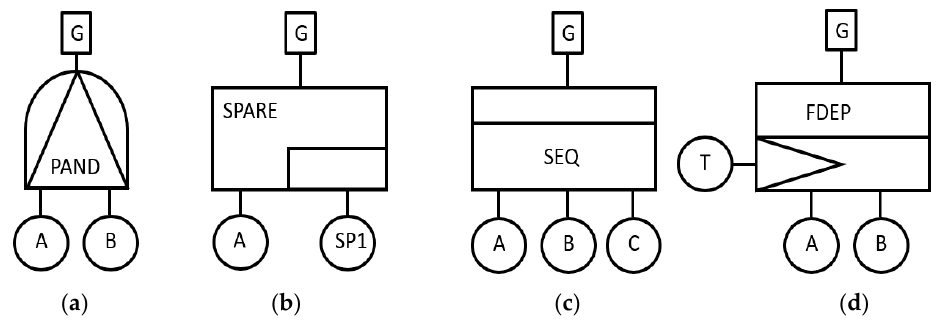
Figure 5. Dynamic gates: ( a ) PAND gate; ( b ) SPARE gate; ( c ) SEQ gate; ( d ) FDEP gate. The priority AND (PAND) gate is similar to an AND gate, but its output depends on a basic event on the left (A) occurring before an event on the right (B). Therefore, logical expressions for deriving the output of the PAND gate can be represented, as shown in Table 2. In other words, the failure time of B ( T B ) is considered as an output of gate only when it is smaller than the mission time ( T M ) and larger than the failure time of A ( T A ) ,